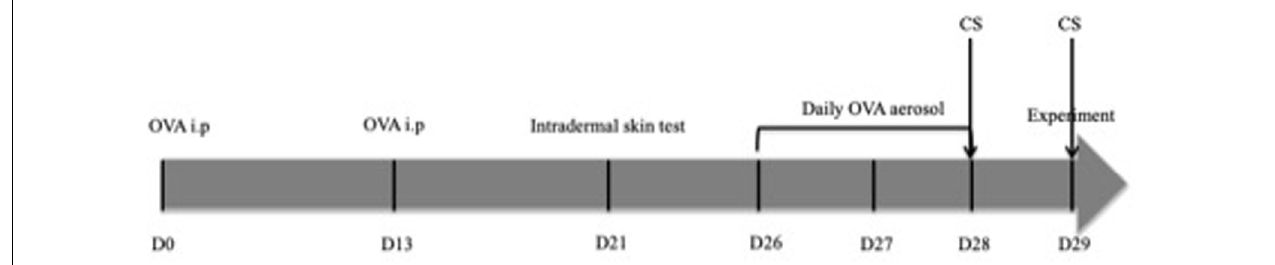
FIGURE 1 | Timeline of pre-experimental interventions. CS only concerns rabbits in the “OVA-Corticoids IV” group. (i.p., intra-peritoneal injection; CS, corticosteroids; OVA, ovalbumin; D0, Day 0).